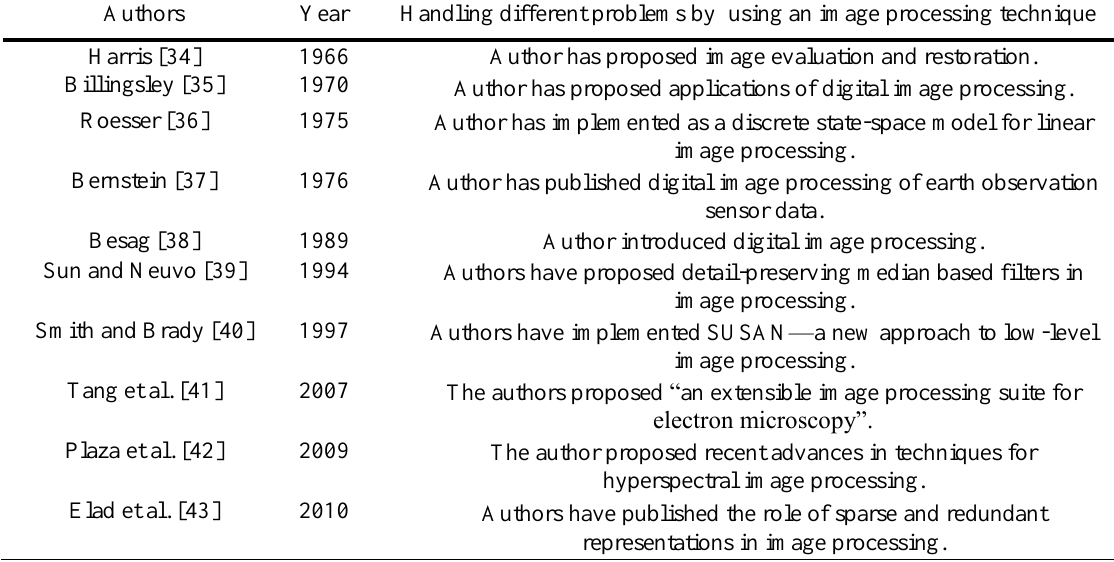
Table 1. A literature review of image